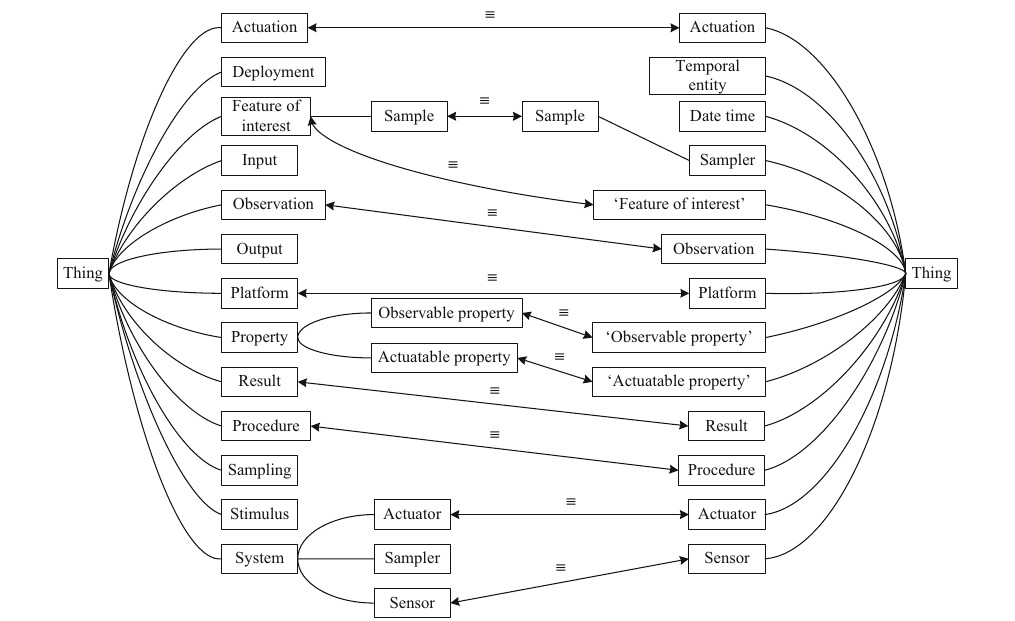
Fig. 2 Two heterogeneous sensor ontologies and their matching results